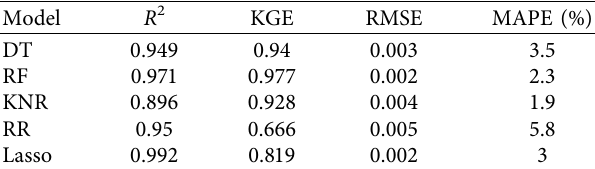
Table 2: Te calculated performance metrics for the gas shape factor over the testing phase.